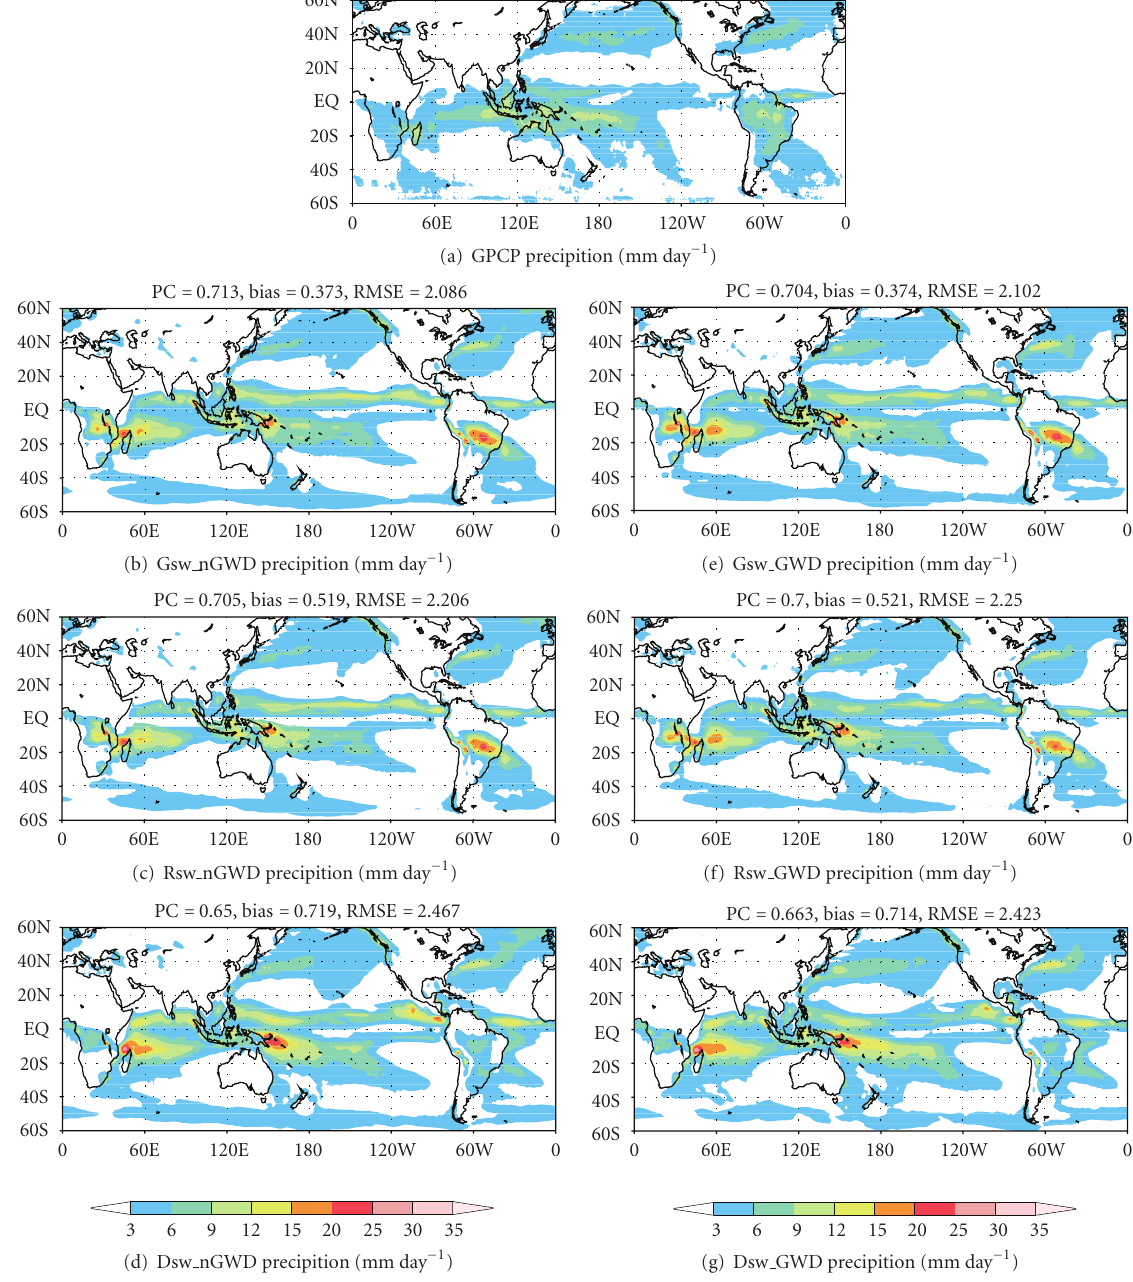
Figure 3: Comparison of 3-year averaged daily precipitation (mm day − 1 ) obtained from (a) observations, (b), (c), (d) the experiments without the KA GWDO scheme and with three di ff erent shortwave radiation processes, and (e), (f), (g) the experiments including the KA GWDO scheme and with three di ff erent shortwave radiation